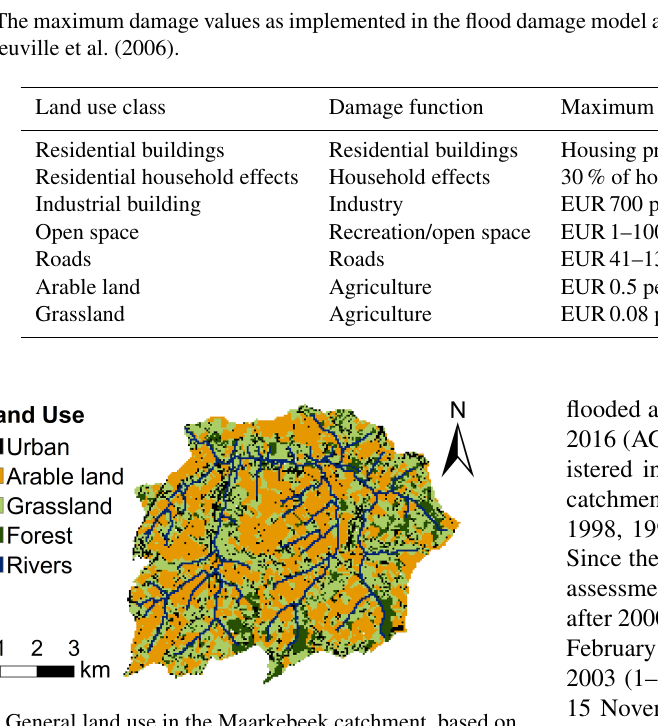
Figure 3. General land use in the Maarkebeek catchment, based on the land use dataset of 2012 (AGIV,